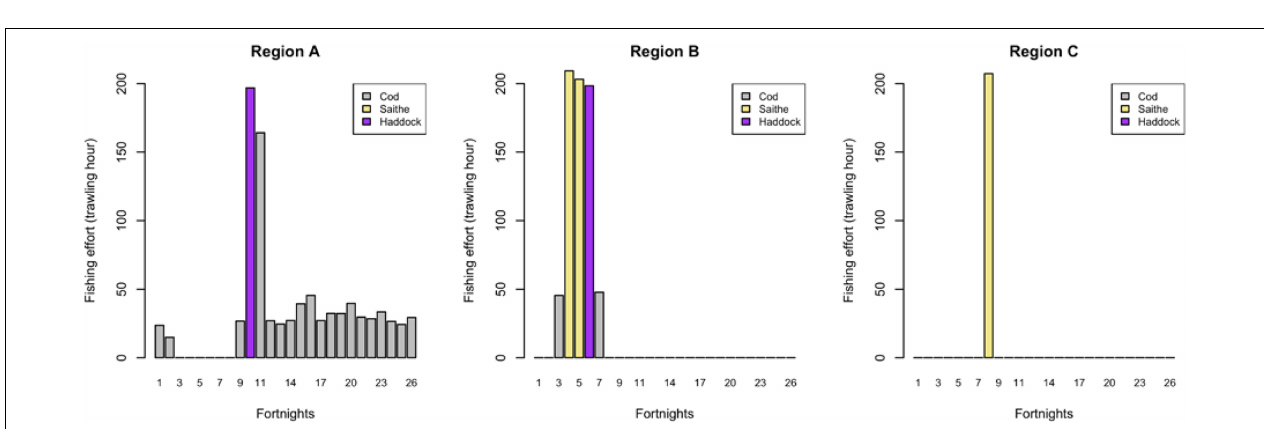
FIGURE 7 | Optimal catch distribution and quota utilization in the cod, saithe, and haddock fisheries in the three selected regions over 26 fortnights.